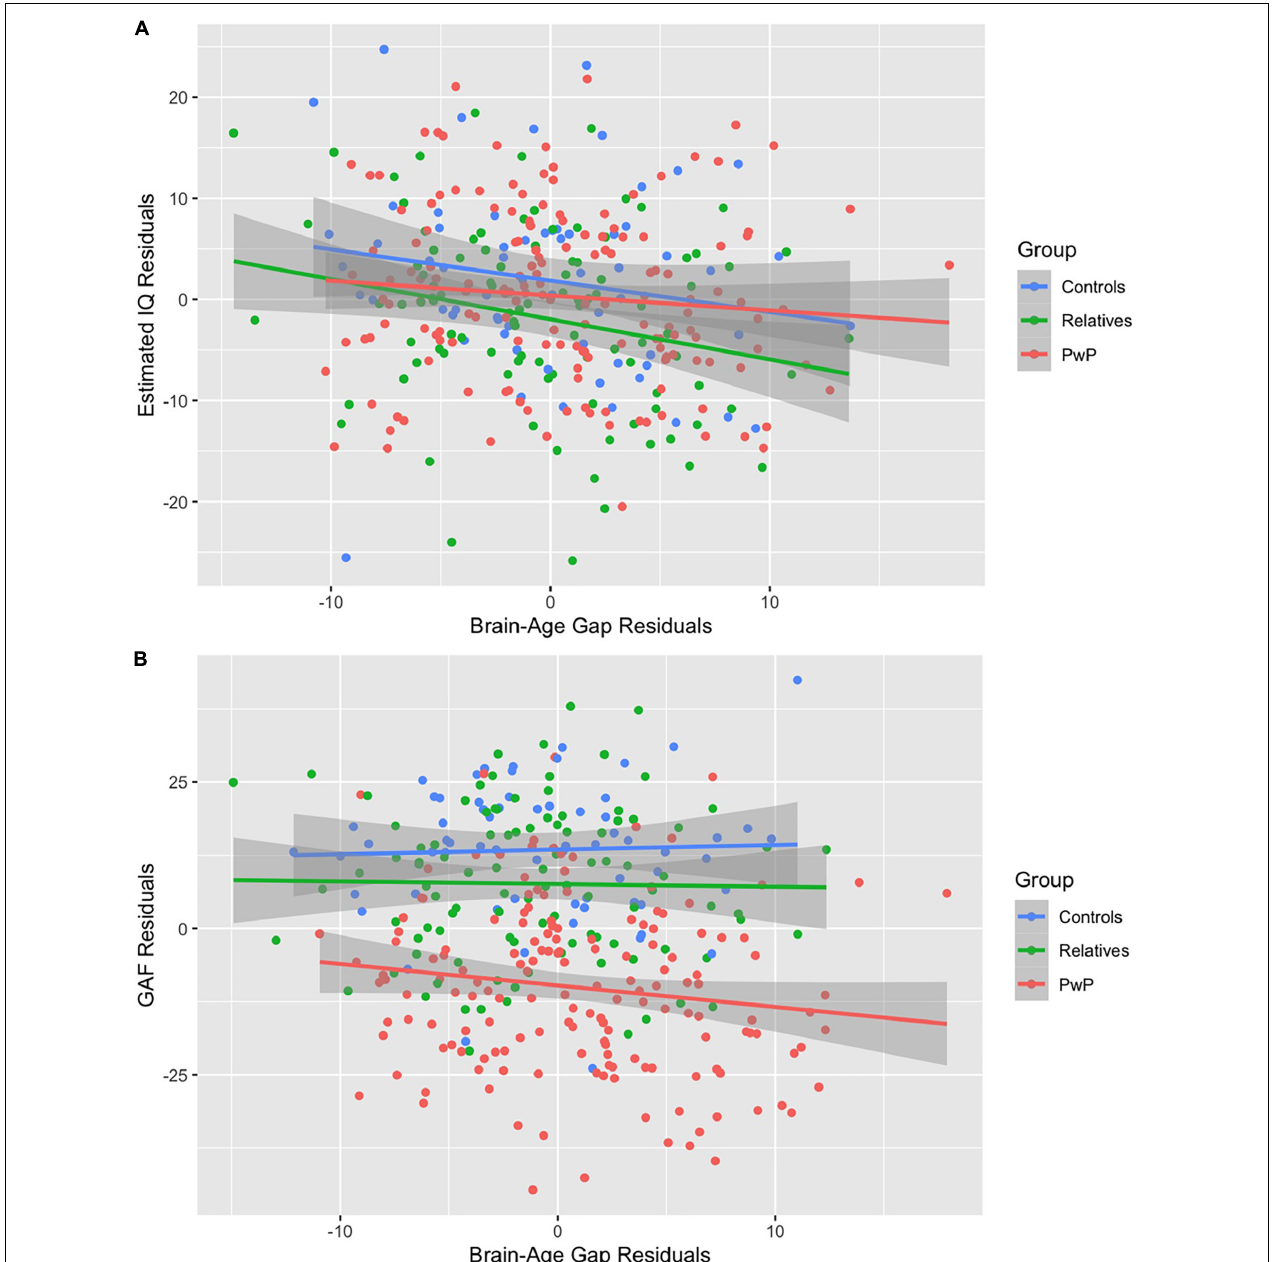
FIGURE 3 | (A,B) Correlations among the full sample. Lower IQ (A) and lower Global Assessment of Functioning (B) predicted larger brain-age gap after adjusting for